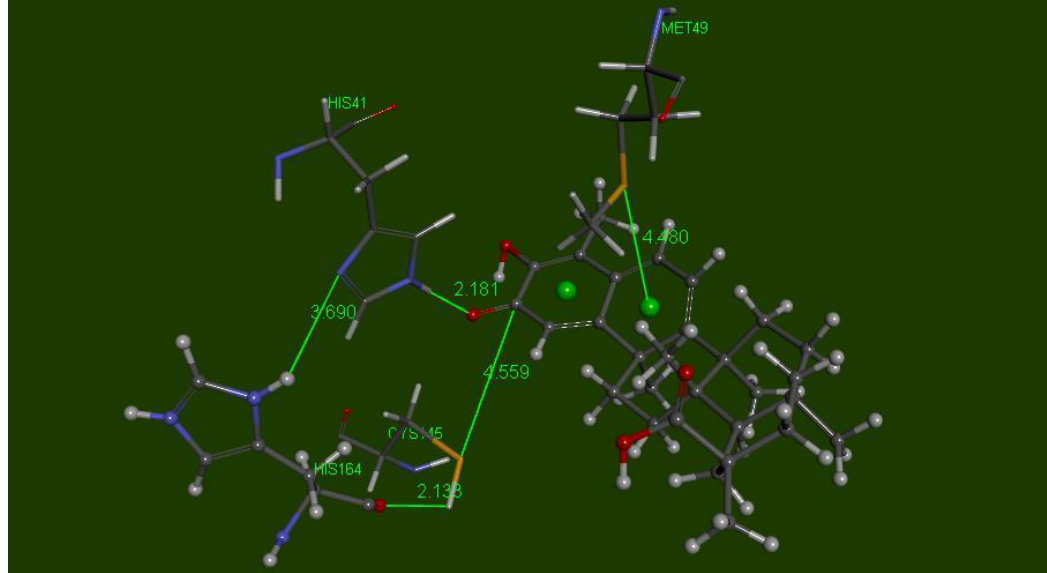
Figure 14. Result of dynamic cascade of docking pose 5 displays His41 closer to the methide quinone carbonyl than in the docking results, d(H-NImidazole) = 2.181 Å , and 3.184 Å , respectively, inducing H capture by the carbonyl. Additionally, O(His164) is closer to H(Cys145), 2.133 Å , compared with the docked structure of 2.492 Å , suggesting H(Cys145) detachment and formation of S(Cys145) thiolate. An evolution of this structural arrangement is shown in Figure 15.